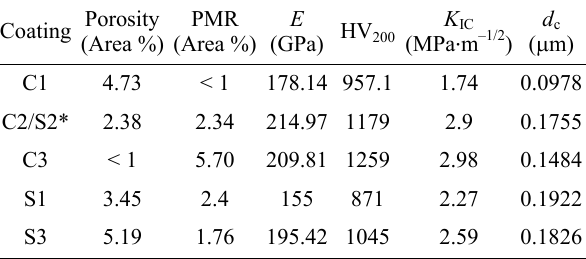
Table 2 Measured morphology and properties of chromia